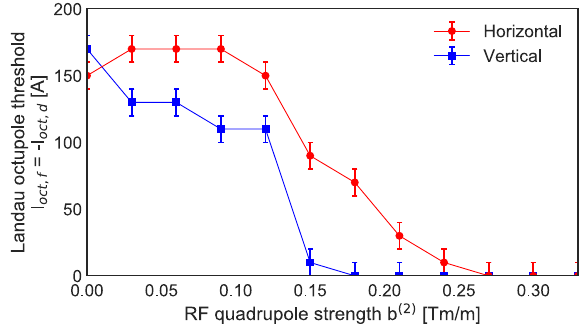
FIG. 15. P y HEADTAIL tracking simulations illustrating the stabilizing efficiency in the horizontal (red) and the vertical (blue) planes with the two-family rf quadrupole scheme.